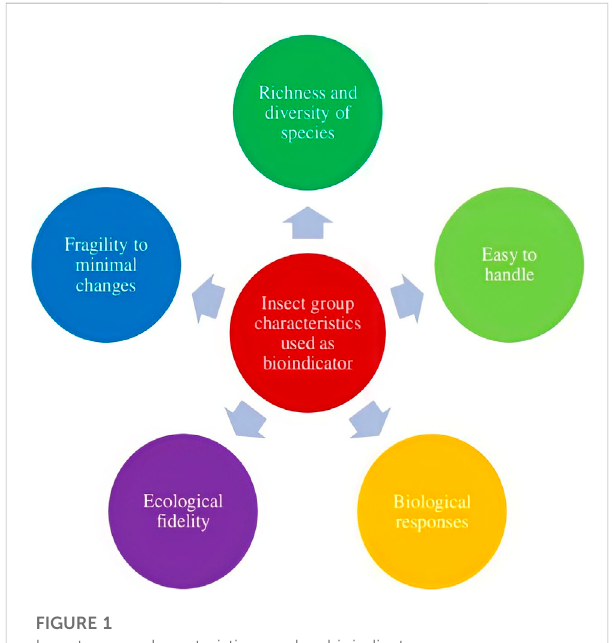
FIGURE 1 Insect group characteristics used as